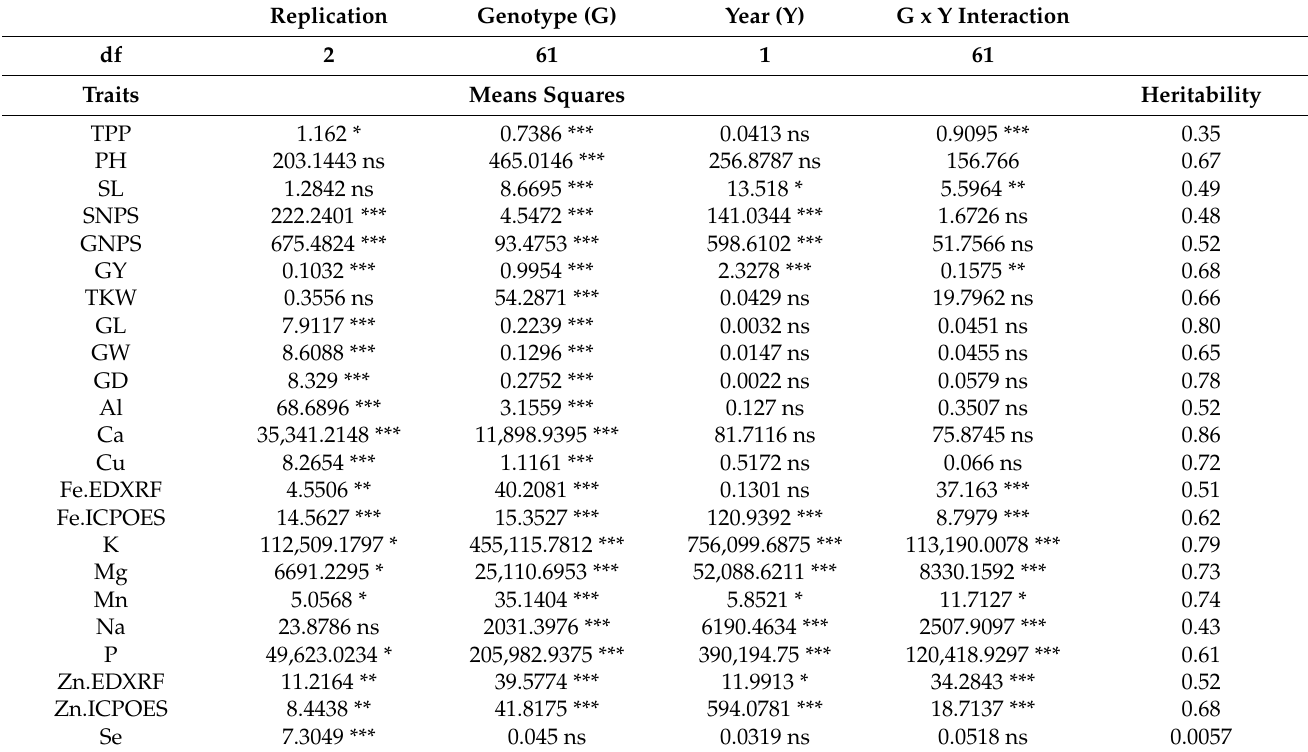
Table 3. Analysis of variance for morphological traits and micronutrient contents in historical wheat cultivars of Pakistan.